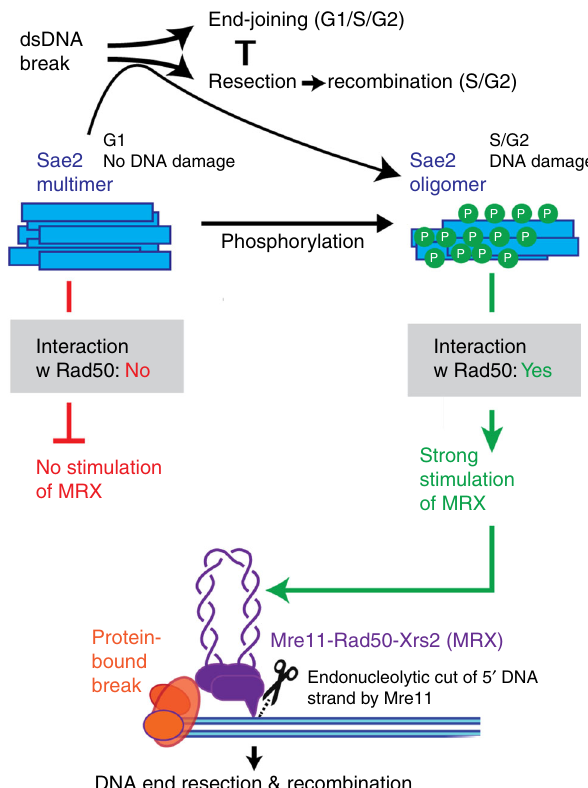
Fig. 7 The function of Sae2 phosphorylation in the control of DNA end resection. Phosphorylation allows the formation of a tetrameric Sae2 form, which is capable of promoting the nuclease activity of Mre11-Rad50-Xrs2 (MRX). Additionally, phosphorylation of the C-terminal part of Sae2 is prerequisite for interaction with Rad50, which is also essential to promote MRX. These phosphorylation-dependent transitions mediate cell cycle and DNA-damage-dependent control of DNA end resection capacity of